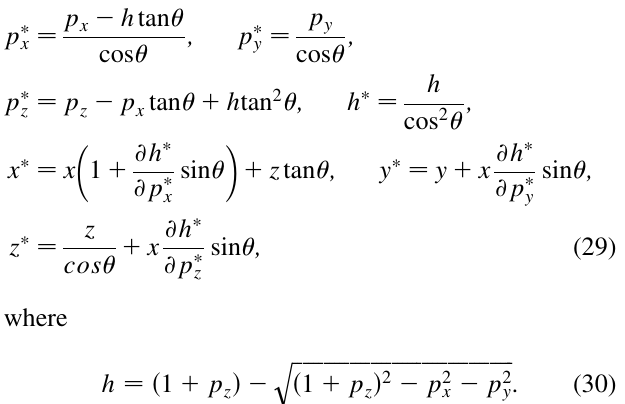
TABLE I. Design parameters of